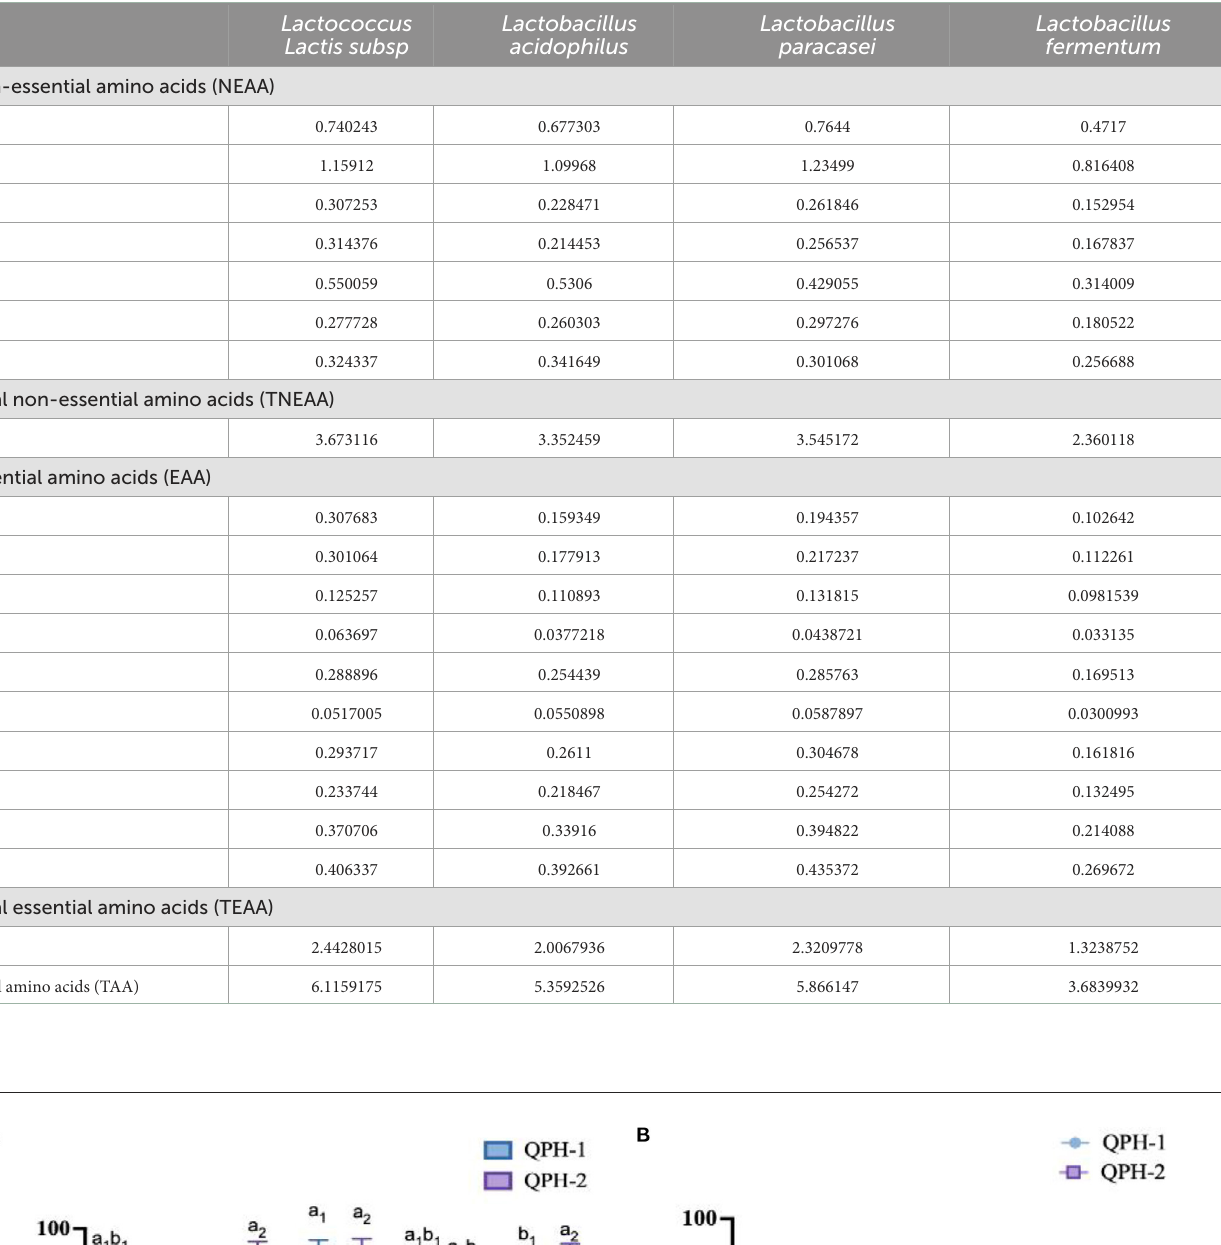
TABLE 3 Amino acid (mg/mL dry matter) content of proteins derived from quinoa.